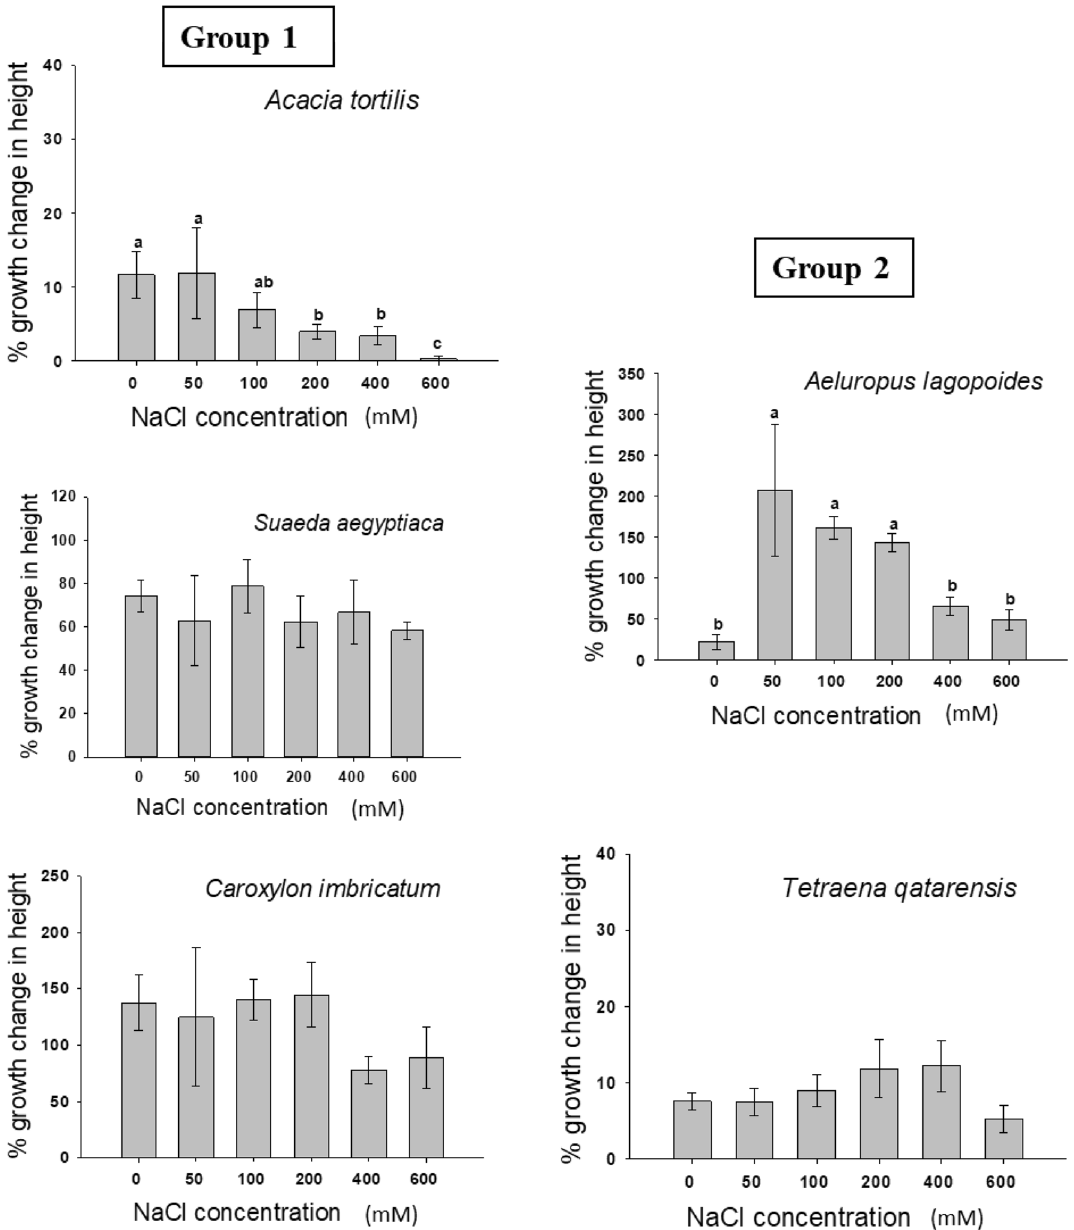
Figure 5. Percent of growth change in height of seedling under the influence of different NaCl concentrations. Values shown are means ± SE. Values in a figure with a common letter are not significantly different according to Tukey’s test at ( p ≤ 0.05). Group-1 refers to plants that had more than 50% germination at concentration equal or less than 200 mM NaCl while Group-2 represents plants that had more than 50% germination at concentration of equal or less than 50 mM NaCl. The absence of letters in a graph means no significance among